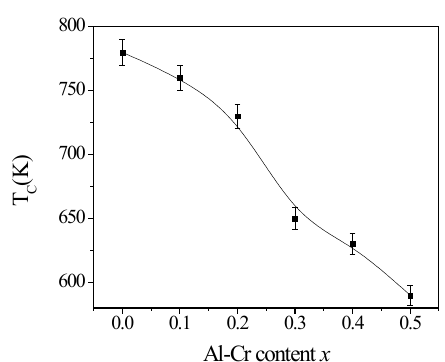
) with Al-Cr content C